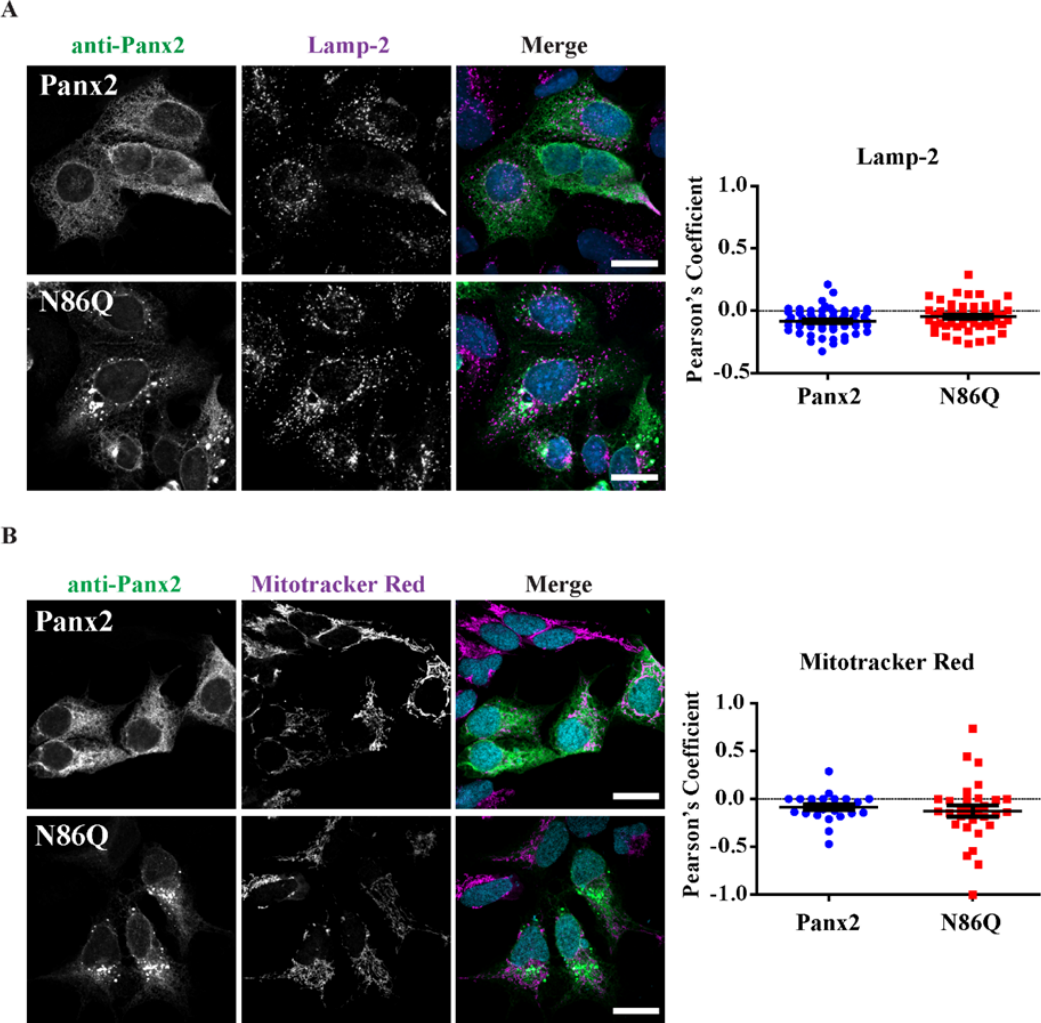
Figure 5. Panx2 and N86Q do not localize to late endosomes/lysosomes or mitochondria. Confocal micrographs of Panx2 and N86Q ectopically expressed in AD293 cells. Co-immunolabeling with anti-Panx2 antibody (green) and organelle markers (magenta): ( A ) Lamp-2, lysosomes and late endosomes, and ( B ) Mitotracker ® Red, mitochondria showed that neither Panx2 or N86Q mutant exhibited significant overlap with the markers. Nuclei (blue) were counterstained with Hoechst 33342. Nuclei (blue) were counterstained with Hoechst 33342. Scale bars = 20 µ m. Pearson Correlation Coefficients (right) were calculated for multiples ROIs corresponding to double-labeled cells. There was no statistical significance ( p > 0.05, N = 3, unpaired two-tailed t test with Welch’s correction) in the degree of colocalization between Panx2 and N86Q with the markers. Error bars denote mean ±